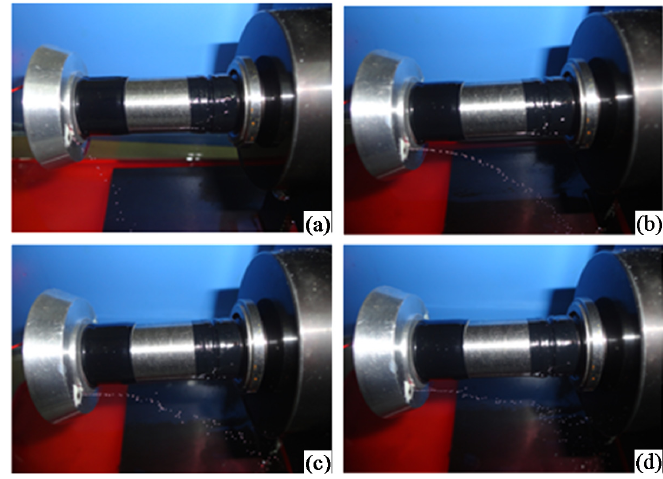
Figure 19. The injection states of the micro-jet under pulse voltages with different duty ratios: ( a ) the duty ratio is 30%; ( b ) the duty ratio is 40%; ( c ) the duty ratio is 50%; ( d ) the duty ratio is 60%.